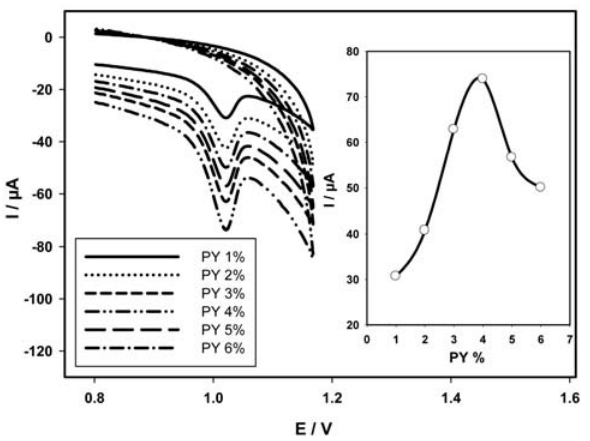
Figure 6: Cyclic voltammograms of 1.0 × 10 –3 mol/L MET solu- tion in BR buffer of pH 2.0 at PYCPE of different contents of PY. Scan rate of 100 mV/s. The inset: plot of the anodic peak current values versus PY content.